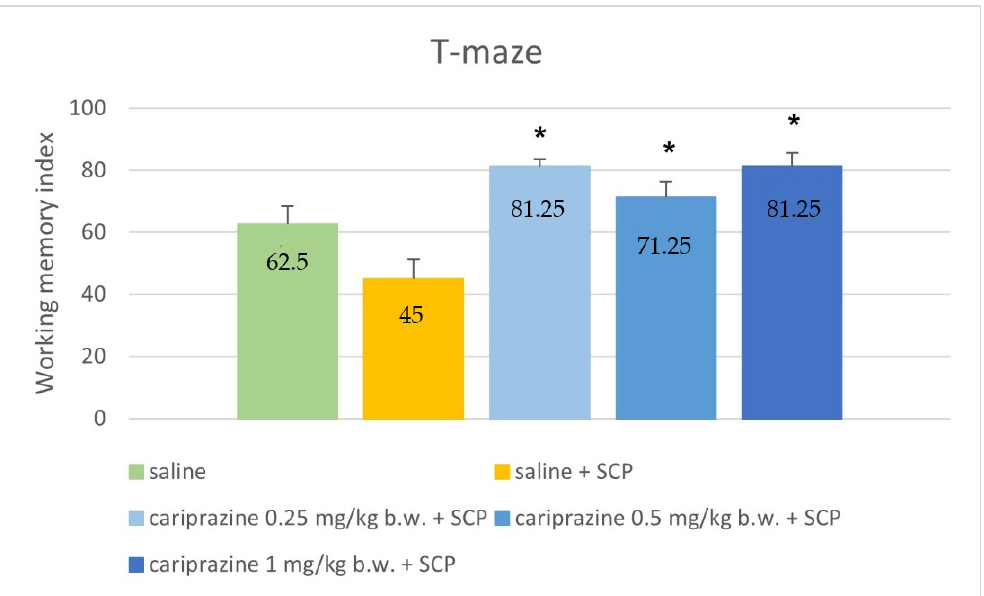
Figure 2. Comparison of working memory index values (percentage) between control groups and groups treated with cariprazine in the T-maze task. SCP—scopolamine * p ≤ 0.05 compared to saline + SCP.